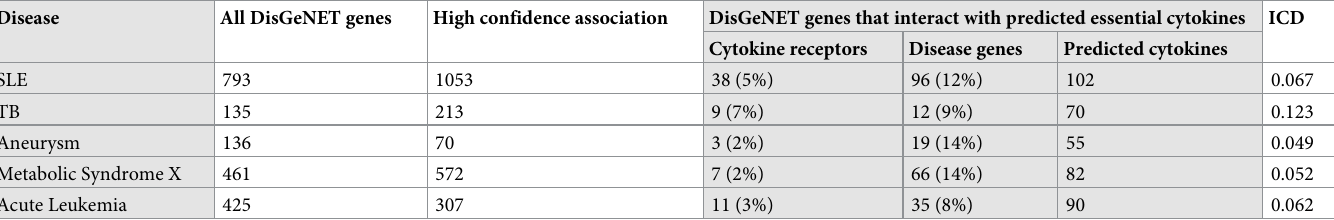
Table 5. Analysis of subnetworks formed by high confidence associations between the known disease associated genes and the predicted cytokines of five diseases. The known DisGeNET genes (column #2) of a given disease often contain cytokine receptors. The number of cytokine receptors and other disease genes captured by high- confidence associations (column #3) is listed in column #4 and column #5, respectively. The number of predicted essential cytokines that interact with receptors and dis- ease genes from DisGeNET is listed in column #6. The Immune Connection Density (ICD) estimated on the subnetworks formed by receptors, disease genes, and essential cytokines is shown in column